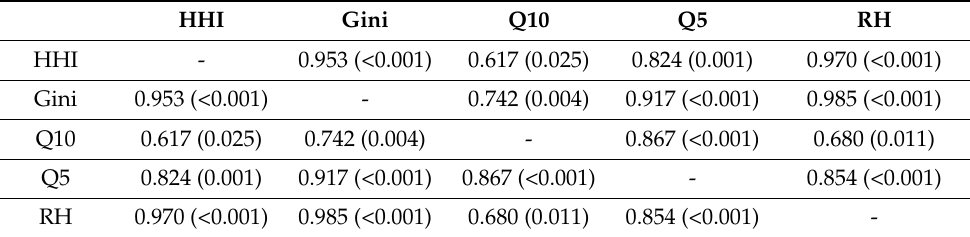
Source: own calculation.